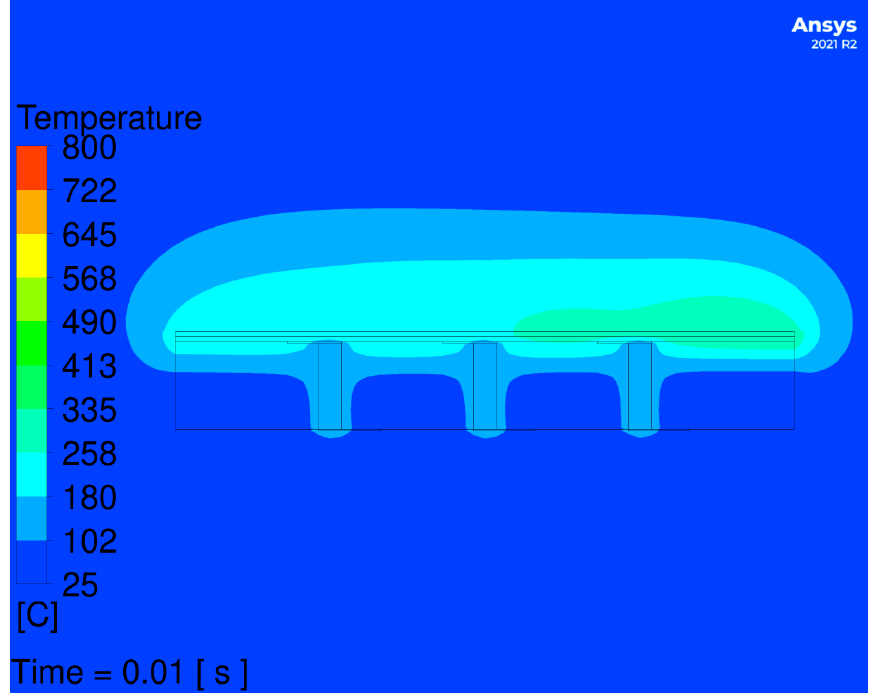
Figure 15. Temperature contours after 10 ms, without solder and silicon.